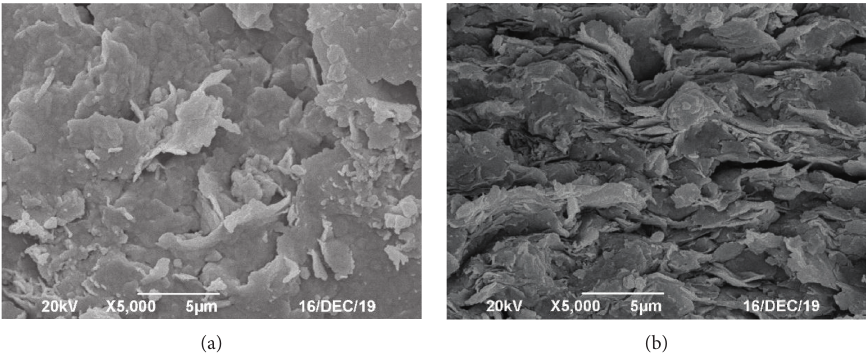
Figure 5: SEM micrographs of the compacted Baise soil sample in (a) vertical direction and (b) horizontal direction.